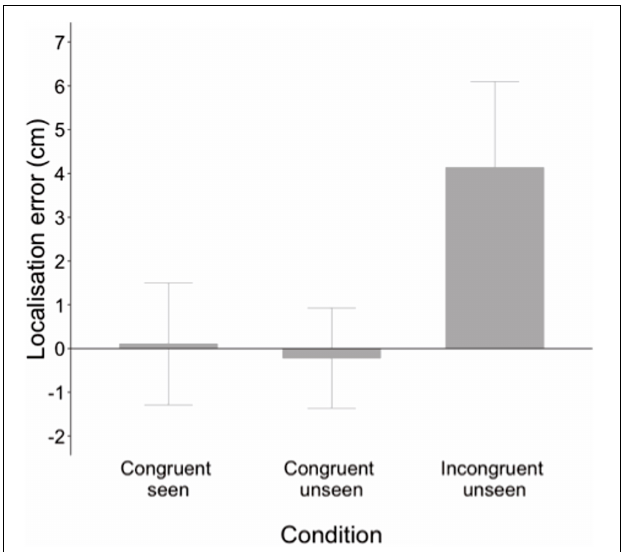
FIGURE 2 | Localization error in cm for each condition across the whole sample. Positive values represent mislocalization to the left of the real hand; negative values represent error to the right of the real hand. Error is low in both congruent conditions, but significantly increased when visual and proprioceptive inputs were incongruent. Error bars ± 1 SD.